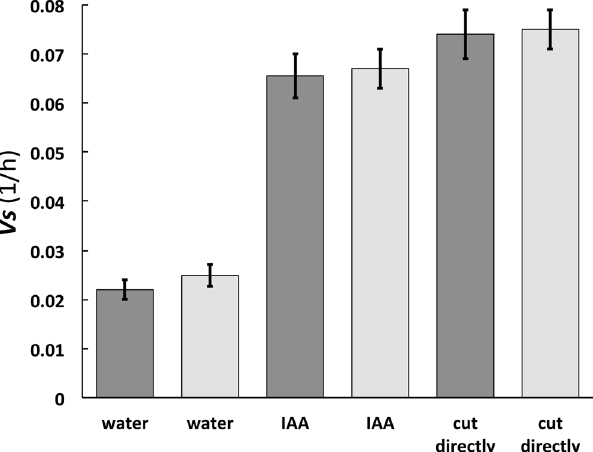
Figure 2. A comparison of v s values calculated (dark grey) and measured (light grey) for cells in pea stems ( P. satinis L.). Equation (9) is employed to calculate v s values (dark grey) using a constant value for Π pe ( Π pe = 32) and values for ε and φ taken from Cosgrove 10 ; see Calculations, Estimates, and Methods for details. The confidence intervals for the measured values (light grey) are standard errors taken from Cosgrove 10 . The confidence intervals for the calculated values (dark grey) represents the maximum and minimum values that can be calculated from maximum and minimum values obtained from standard errors of φ 10 .